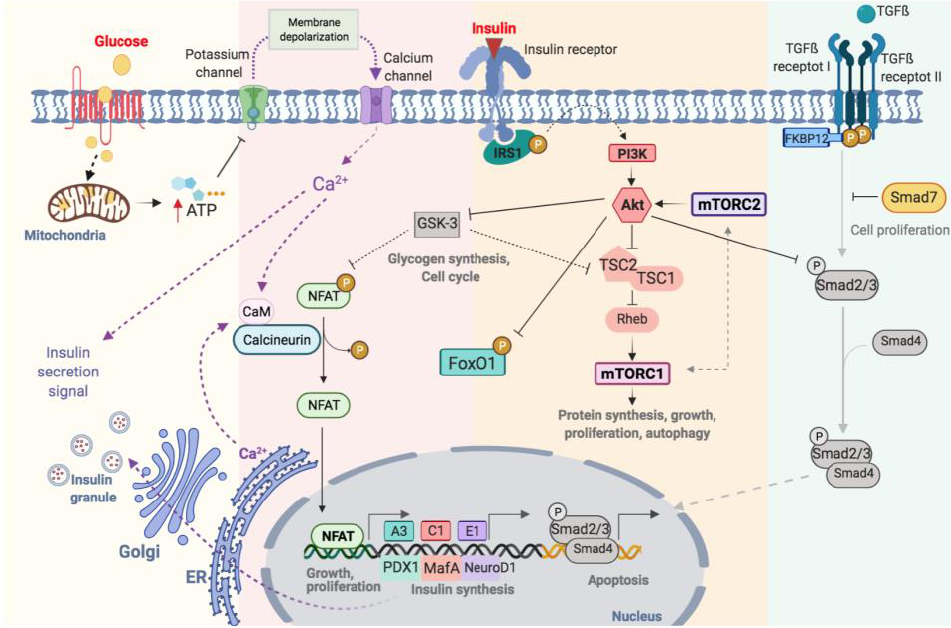
Figure 1. Schematic illustration of functional regulation on pancreatic β–cell.